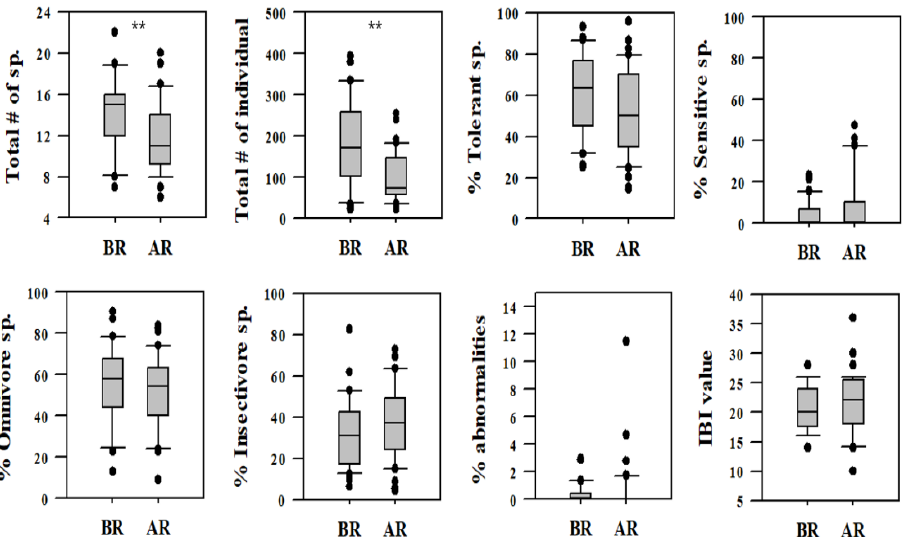
Figure 6. Variation in different fish assemblages (trophic and tolerance guilds) as well as IBI values as ecological health parameters based on restoration measures in Gap-stream (BR = before restoration, 2007–2010; AR = after restoration, 2013–2016, ** = p < 0.01).